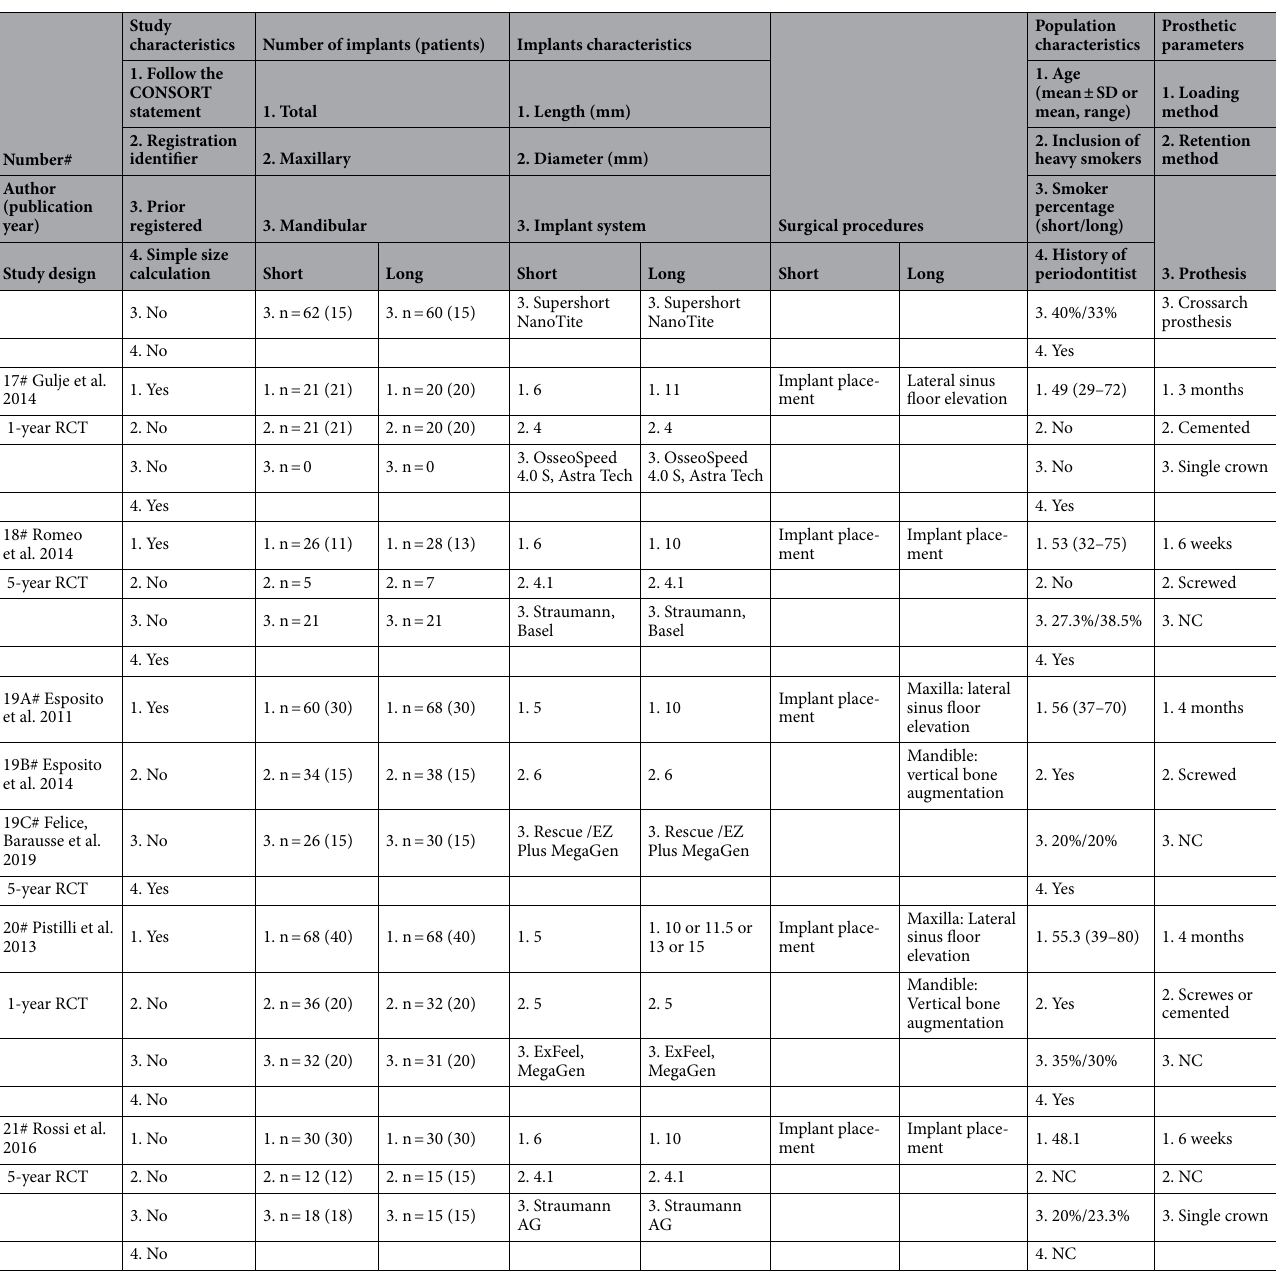
Table 1. Characteristics of included studies. NC, not clear, not reported; FPD, fixed partial denture; RCT, Randomized controlled trail; CONSORT, Consolidated Standards of Reporting